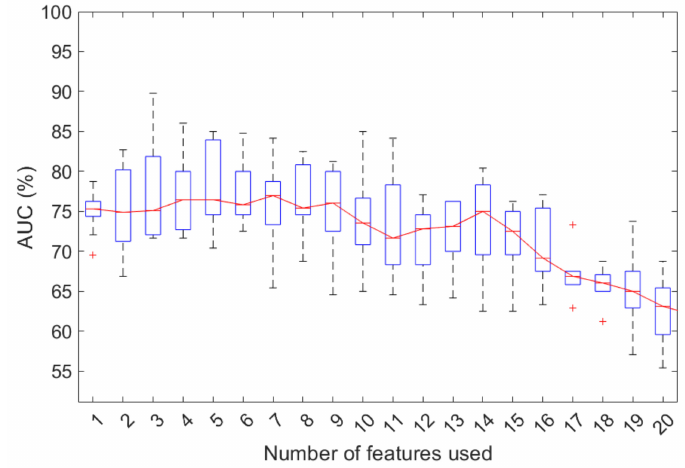
Figure 2. Classification performances to predict the initial response to therapy for an increasing num- ber of features selected by the stepwise forward selection procedure in 100 tenfold cross-validation rounds. +: outliers of the distribution. Table 2. Occurrence frequency of the selected features in the first seven iterations using the sequential forward procedure in 100 tenfold cross-validation